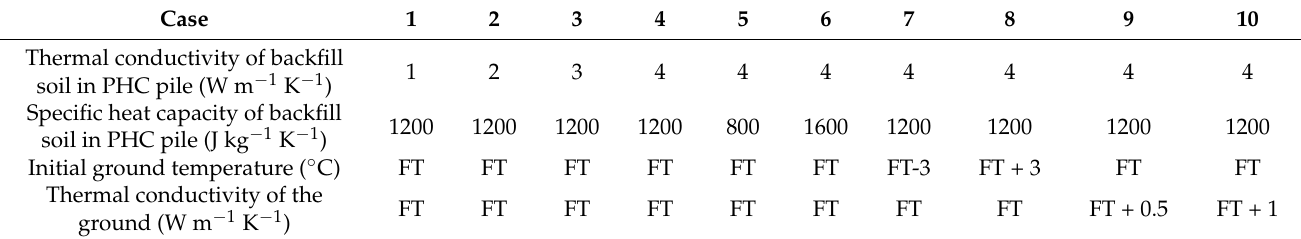
Table 4. Different parameters considered in each case of the thermal response